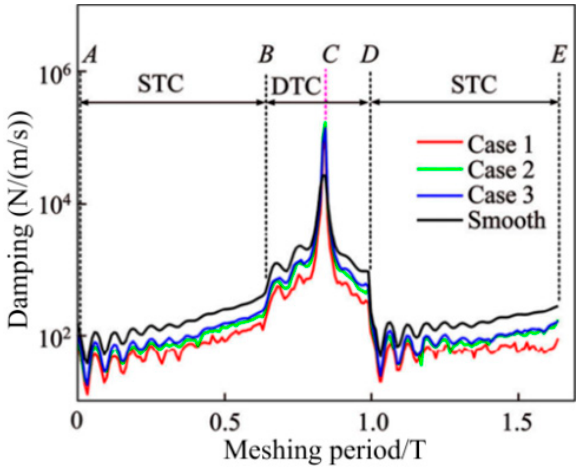
Figure 9. Viscous damping of MGPs with CIMT.